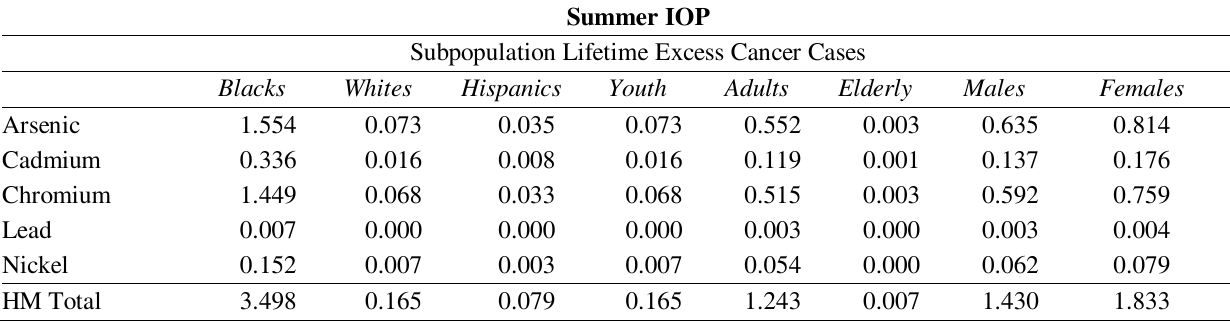
Table 5: Summer IOP Lifetime Excess Lung Cancer Cases by DC Subpopulations